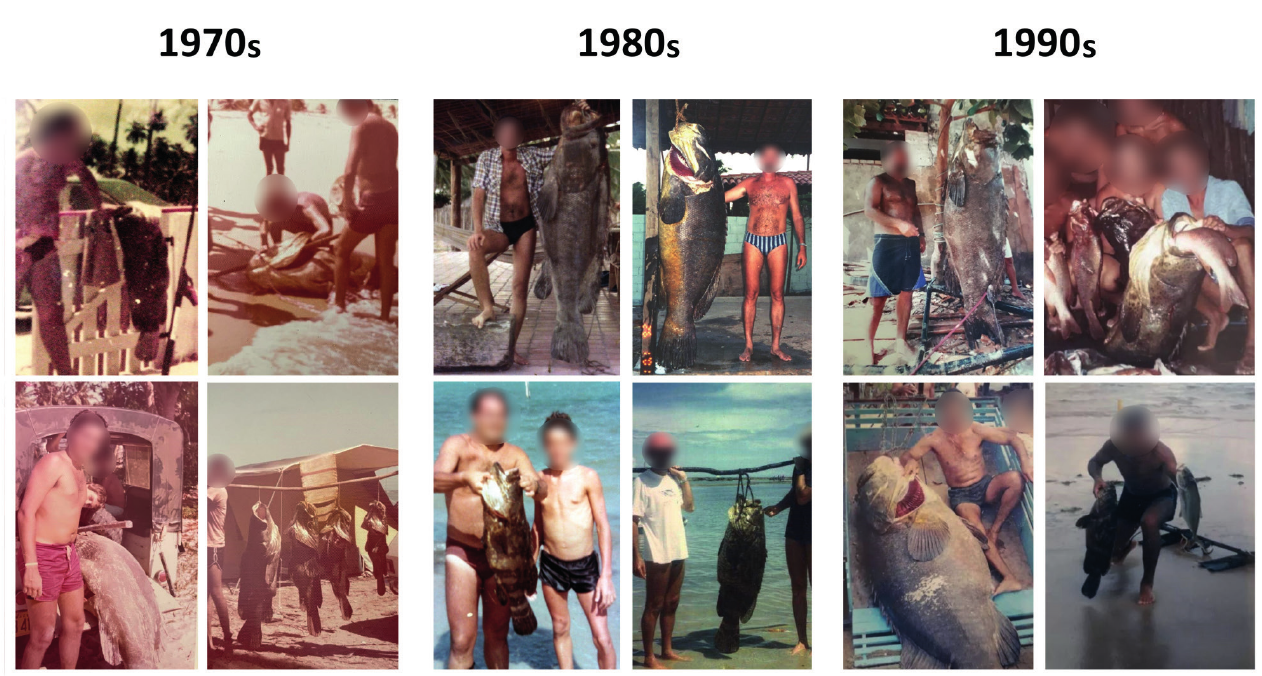
FIGURE 4 | Photographic records from the pre-moratorium period, from the 1970s, 1980s, and 1990s. All images are of captures made through spearfishing in shallow coastal reefs off the Alagoas